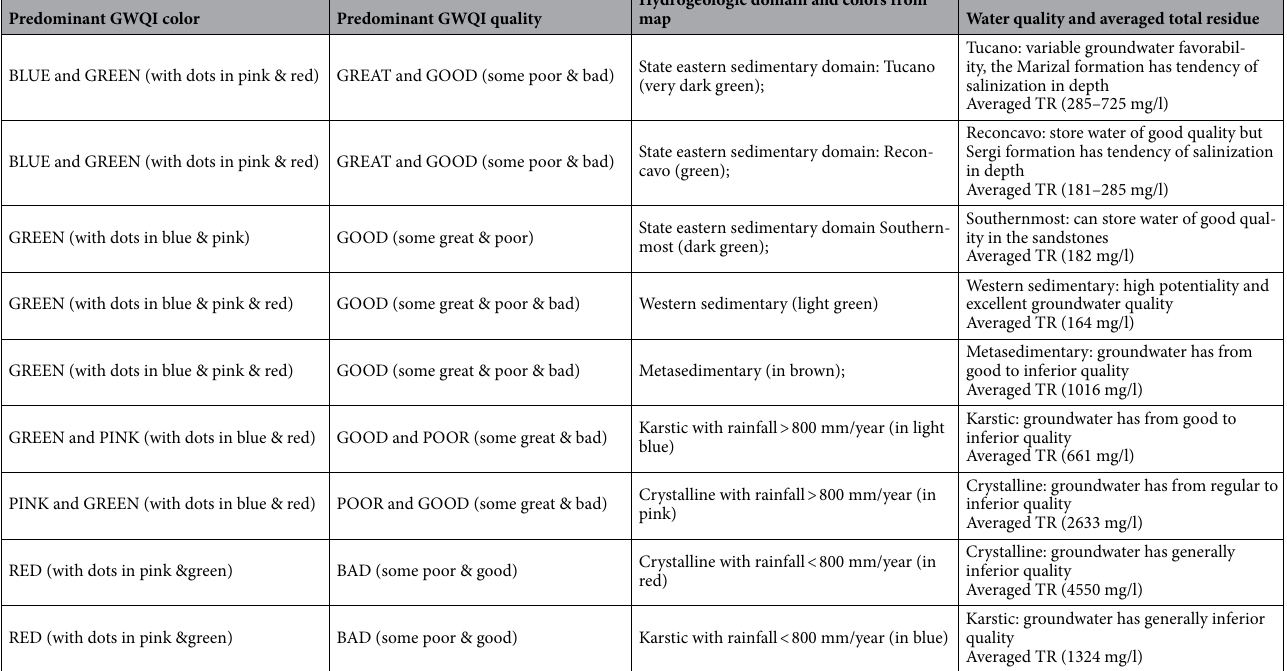
Table 10. GWQI colors (quality indicators), the hydrogeologic domain, and the respective groundwater